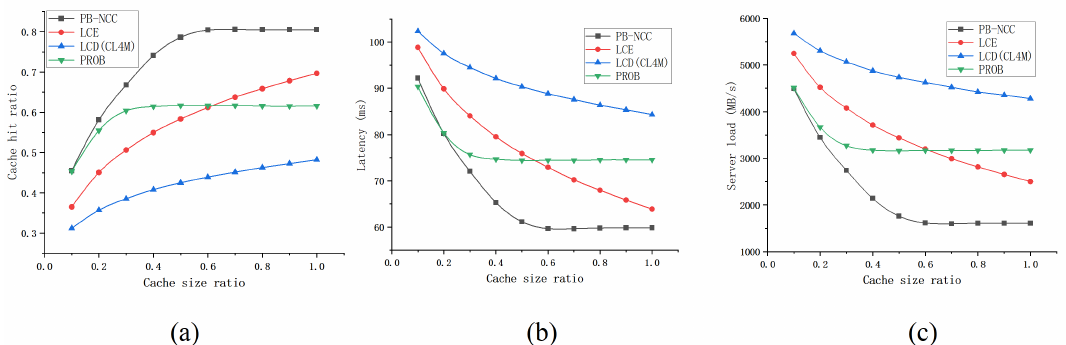
Figure 8. Comparison in the tree topology when the cache size ratio changes. ( a ) the cache hit ratio under a different cache size ratio; ( b ) the average latency under a different cache size ratio; ( c ) the server load under a different cache size